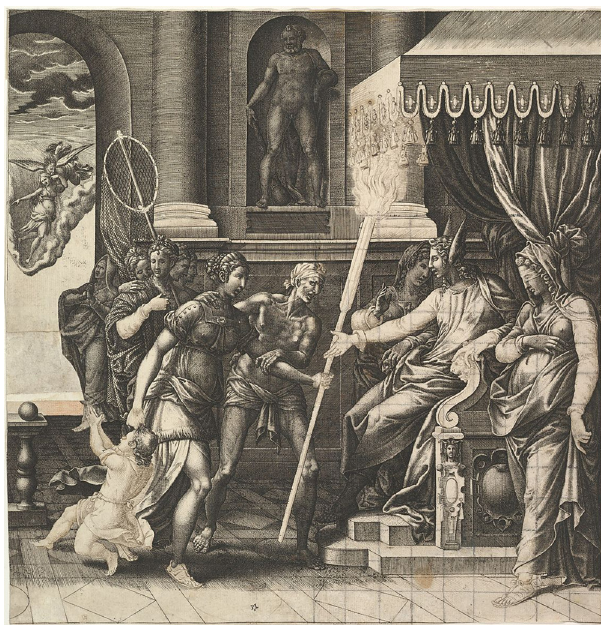
Figure 14: Giorgio Ghisi, Calunnia , 1560. Metropolitan Museum of Art, NYC. Public Domain.